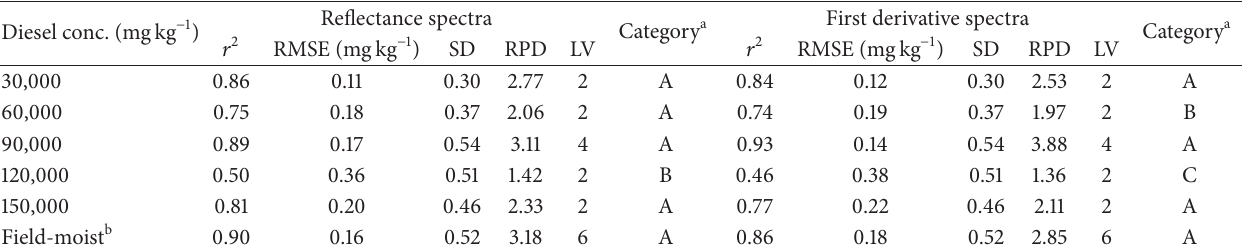
Table 2: Summary of calibration results for phenanthrene obtained by partial least-squares (PLS) cross-validation analysis carried out with spectra and chemical variables of 25 samples for various concentrations of diesel and moisture and clay contents.